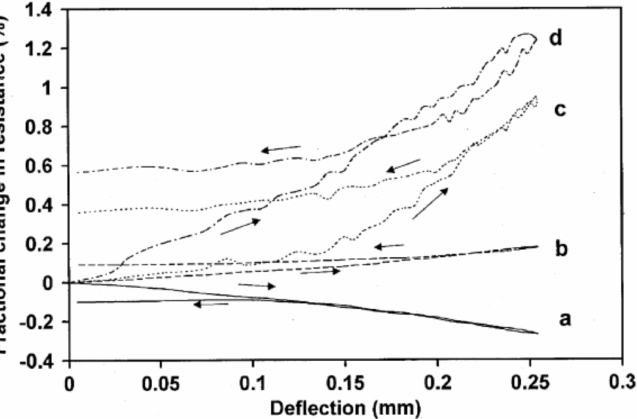
Figure 18. Variation of fractional change in resistance versus deflection at loading and unloading stage in the 1st loading cycle: (a) compression side surface resistance; (b) through-thickness resistance; (c) tensile side surface resistance; and (d) oblique resistance. Reproduced with permission from [40], Elsevier, 2006.